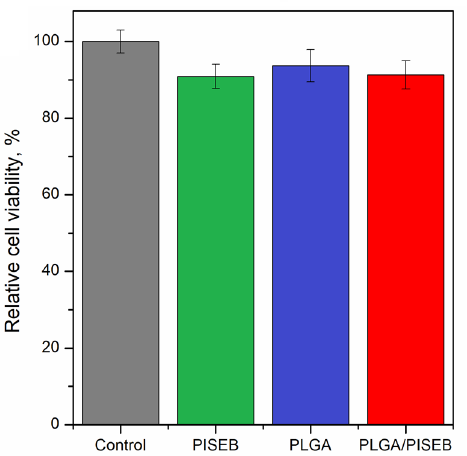
Figure 6. Relative cell viability of HUVEC cells cultured for 48 h on the surface of a tissue culture plastic control, drop-casted PISEB layer, electrospun PLGA scaffolds, and electrospun PLGA/PISEB scaffolds.